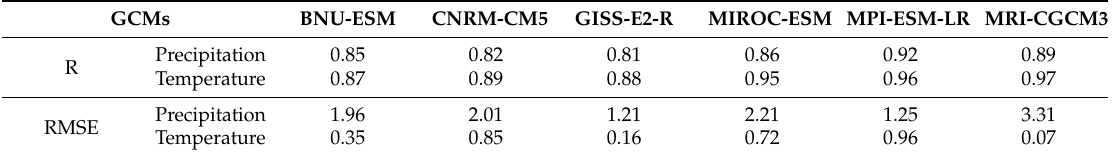
Table 5. Validation results of the daily meteorology data generated by LARS ‐ WG and the observed data using R and RMSE.